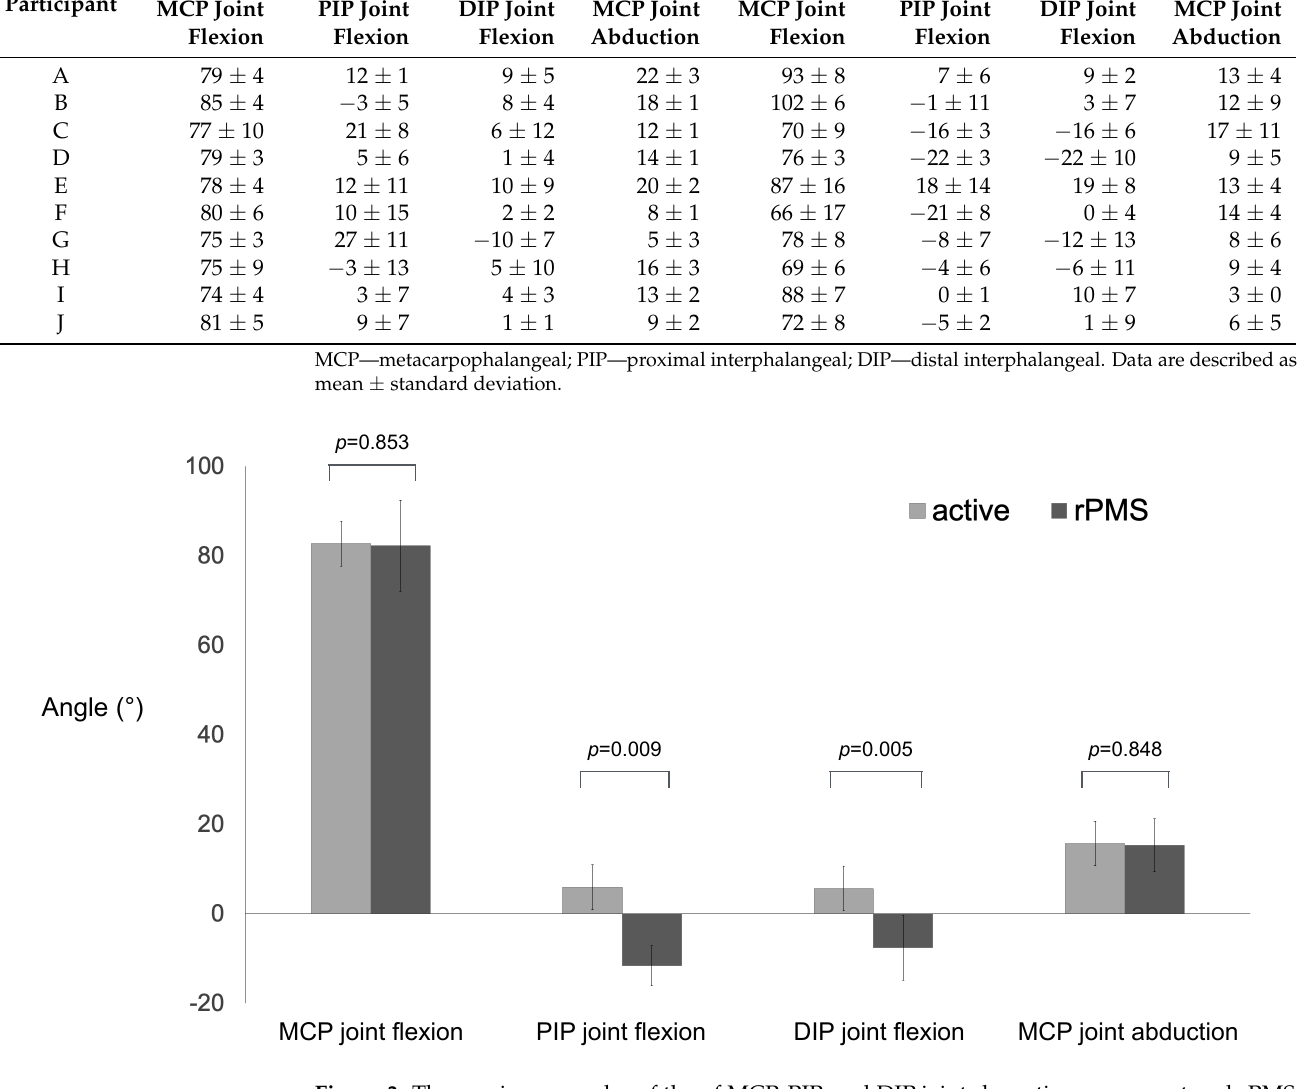
Figure 3. The maximum angles of the of MCP, PIP, and DIP joints by active movement and rPMS. There were no significant differences in the maximum angles of flexion and abduction of the MCP joint. rPMS extended the PIP and DIP joints significantly